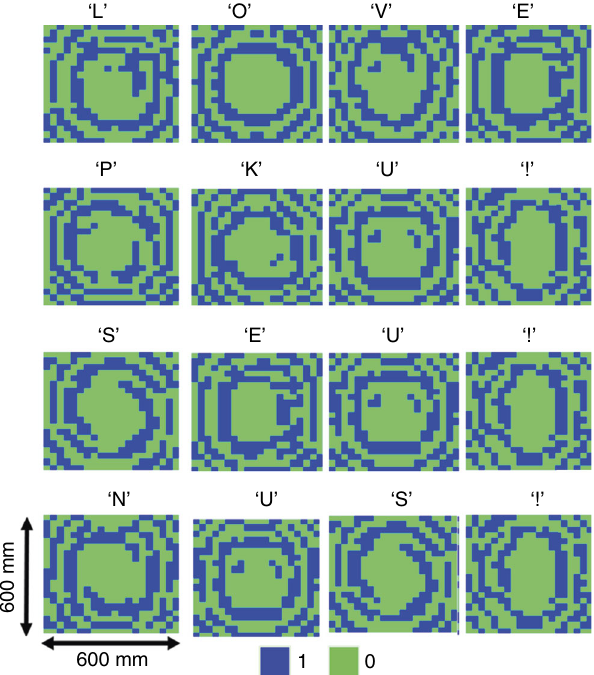
Fig. 3 The binary phase pro fi les of the coding metasurface for different holographic images. The binary holograms for a sequence of letters of ‘ LOVE PKU! SEU! NUS! ’ are generated by the modi fi ed GS algorithm that could be realized by switching the states of corresponding unit cells of the coding metasurface